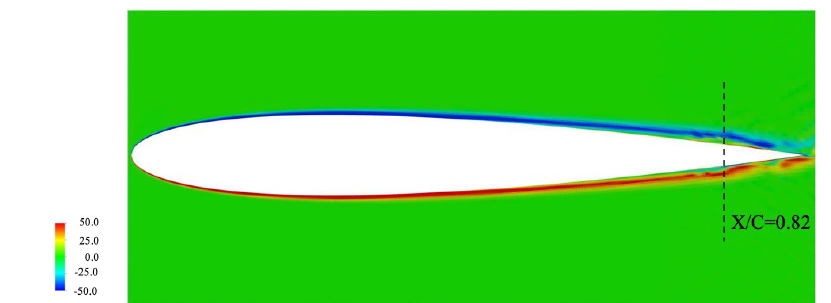
Figure 13. Instantaneous distribution of ω z around NACA0012 airfoil: colored by | ω z | ≤ 50.